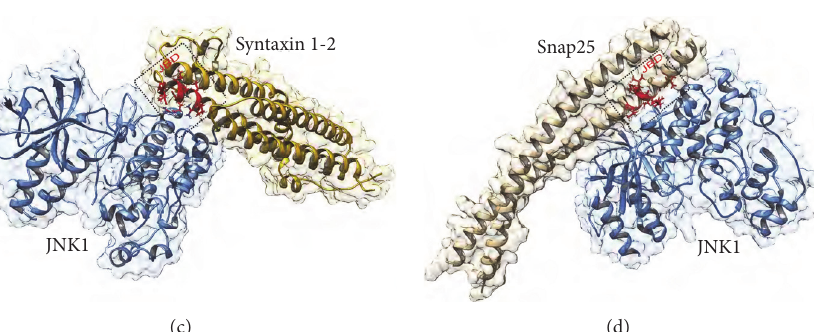
Figure 3: JBD is crucial for SNARE interaction with JNK. (a) Sequence alignment between Syntaxin-1 and Syntaxin-2. The JBDs are underlined in red. (b) Sequence of Snap25 with the JBD underlined in red. On top of panels (a) and (b) the canonical JBD pattern is also reported. (c) Best JNK-Syntaxin complex resulting from the docking predictions. JNK is shown in light blue and Syntaxin in gold. The lateral chains of the residues belonging to the JBD are shown in red. (d) Best complex of the JNK-Snap25 docking results. Also in this case JNK is depicted in light blue while Snap25 is shown in light brown. The lateral chains of the residues of the JBD in Snap25 are reported in red.